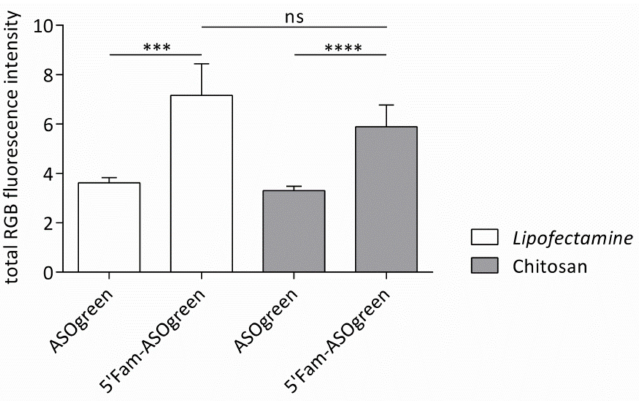
Figure 8. Fluorescence intensities of NCI-H441 cells transfected with ASOgreen and 5 (cid:48) Fam-ASOgreen. Cells were transfected with the fluorescent 5 (cid:48) Fam-ASOgreen as well as the non-fluorescent ASOgreen as controls. Lipofectamine and CS were used as transfection reagents. Total RGB fluorescence intensity was determined 24 h after transfection (non-significant (ns), p ≤ 0.001 (***), p ≤ 0.0001 (****); n =